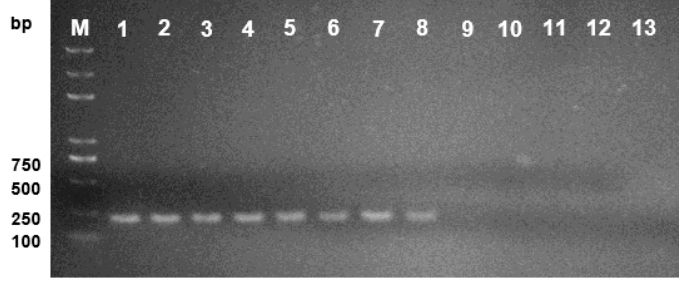
Figure 6. Optimization of the annealing temperature. Lane 1–12 are results from the annealing temperature of 50, 50.7, 51.7, 53.1, 54.7, 56.4, 58.1, 59.8, 61.4, 62.7, 63.8, and 64.4 °C, respectively in reactions using DNA template of D. citri isolate NFHF-8-4. Lane 13 is the ddH 2 O as the template and lane M, 100 bp